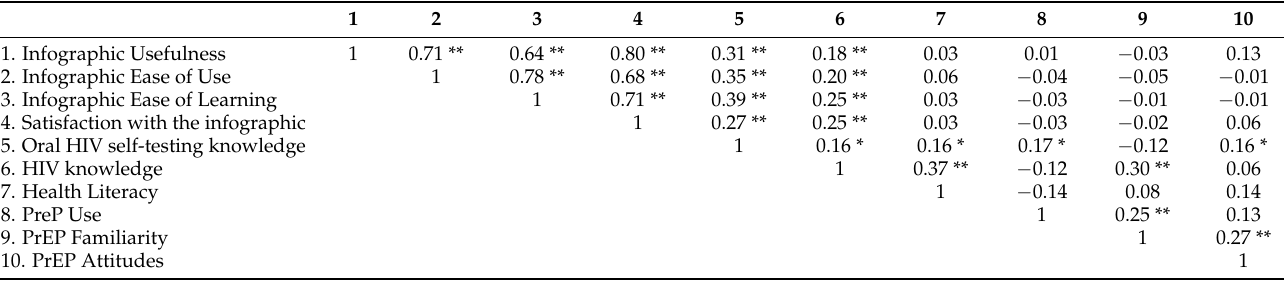
Table 5. Correlation matrix of main analytic measures among experimental group participants ( n = 161).